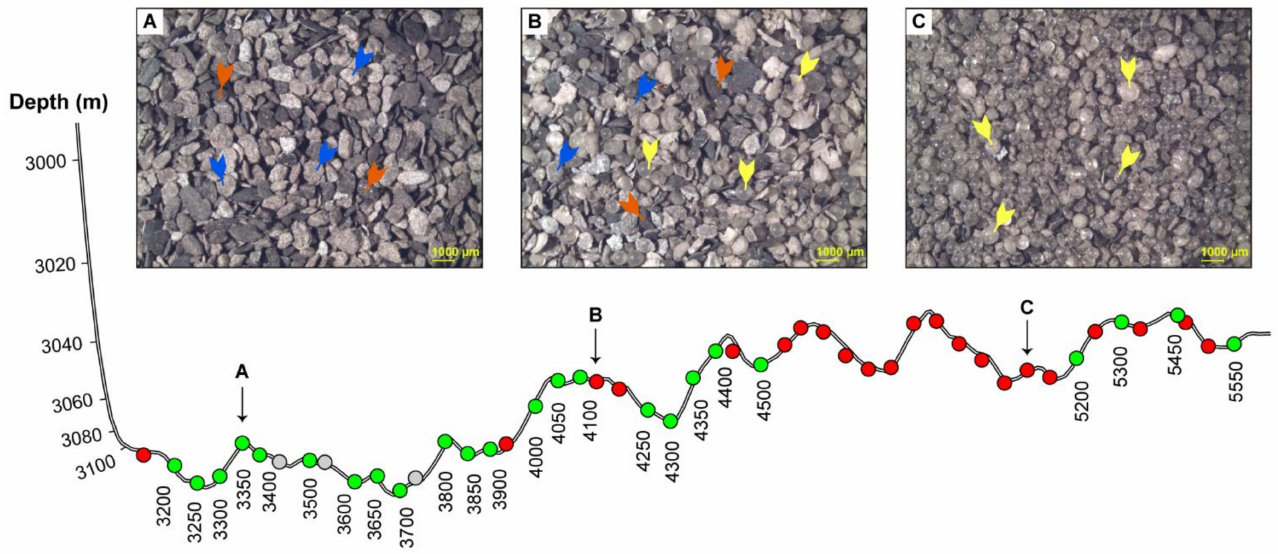
Figure 1. Well trajectory displaying the distribution of drill cutting samples collected along the horizontal well. Green dots represent the samples suitable for laboratory analyses, while the red dots represent samples where mud contaminants were found in amounts exceeding the amount of rock. Stereo images ( A – C ) are examples of drill cuttings at the locations identified in the well trajectory. Yellow arrows in ( A – C ) indicate polymer beads (mud additives). Blue and orange arrows in ( A – C ) represent siltstone and organic-rich mudstone facies,